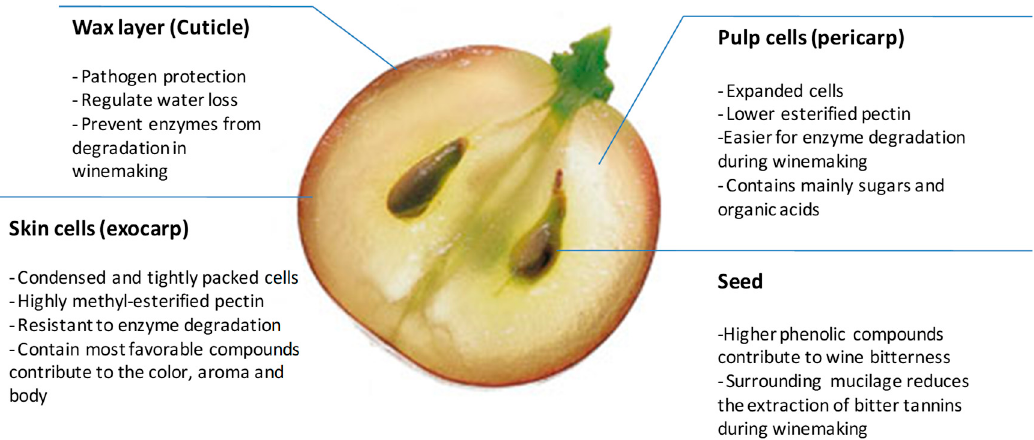
Figure 2. The biological anatomy and biochemical composition of a typical wine grape berry with reference to extractable components.